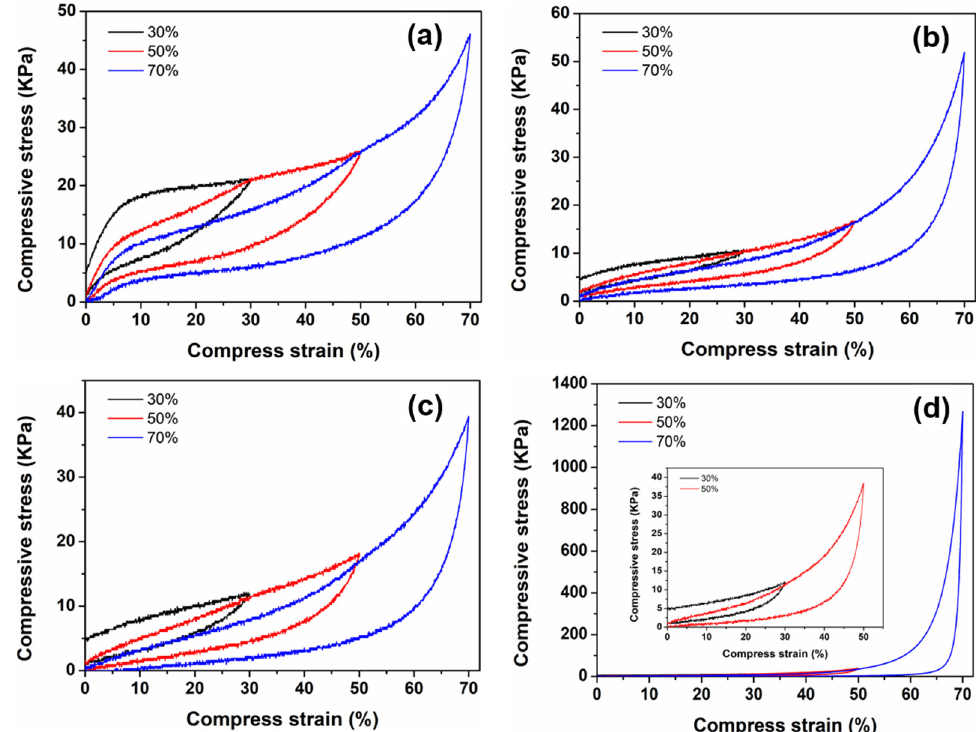
Figure 4. The stress-strain curves of the MF-T ( a ), MF ( b ), MF/PmPD ( c ) and MF/Ti 3 C 2 T x /PmPD ( d ) at different strains of 30%, 50% and 70%, respectively.